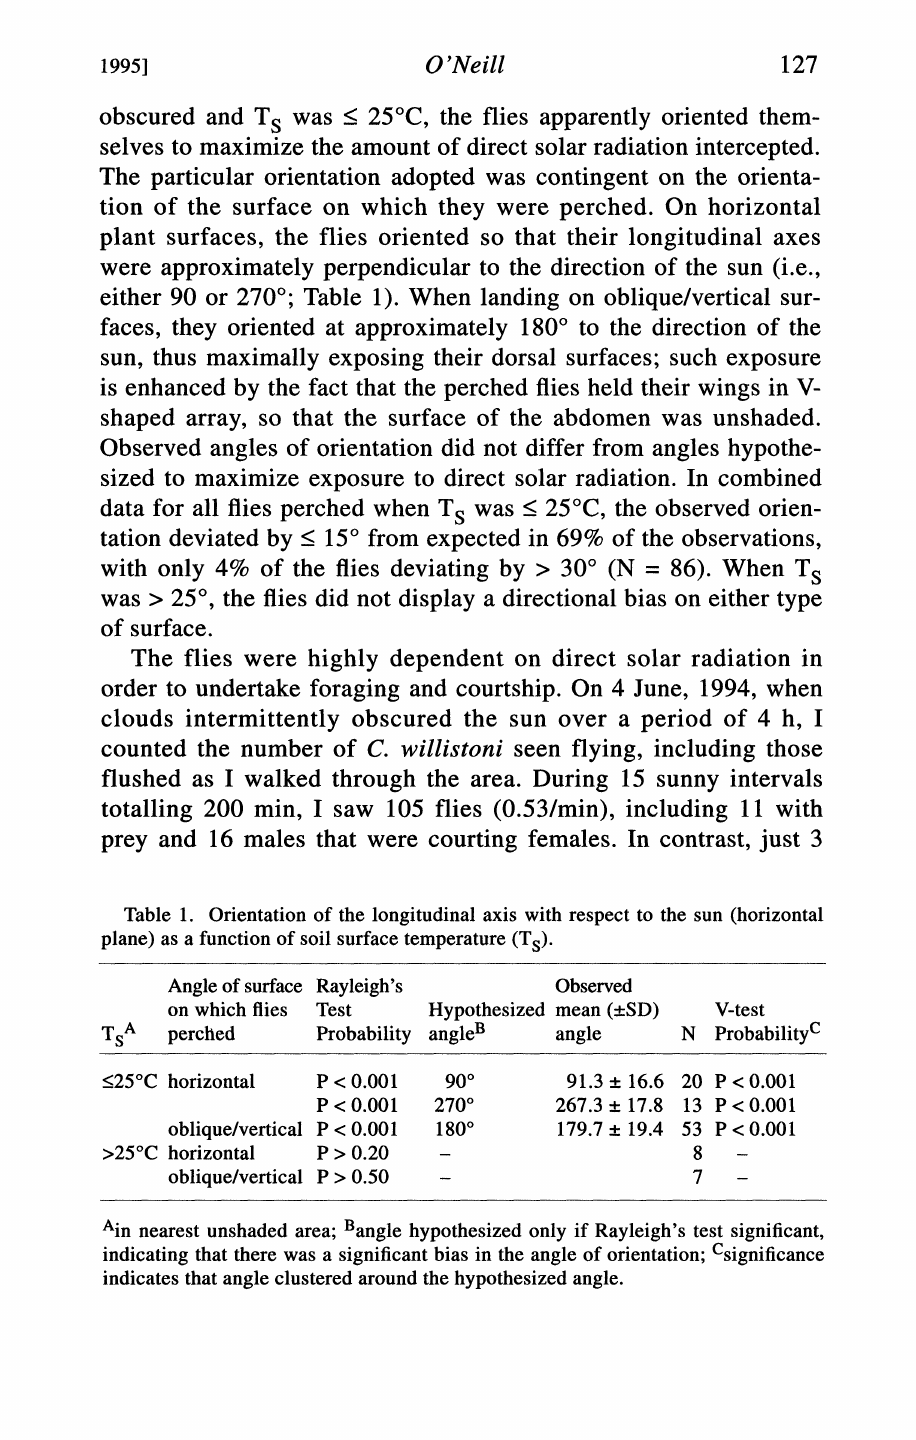
Table 1. Orientation of the longitudinal axis with respect to the sun (horizontal plane) as a function of soil surface temperature (Ts). Angle of surface